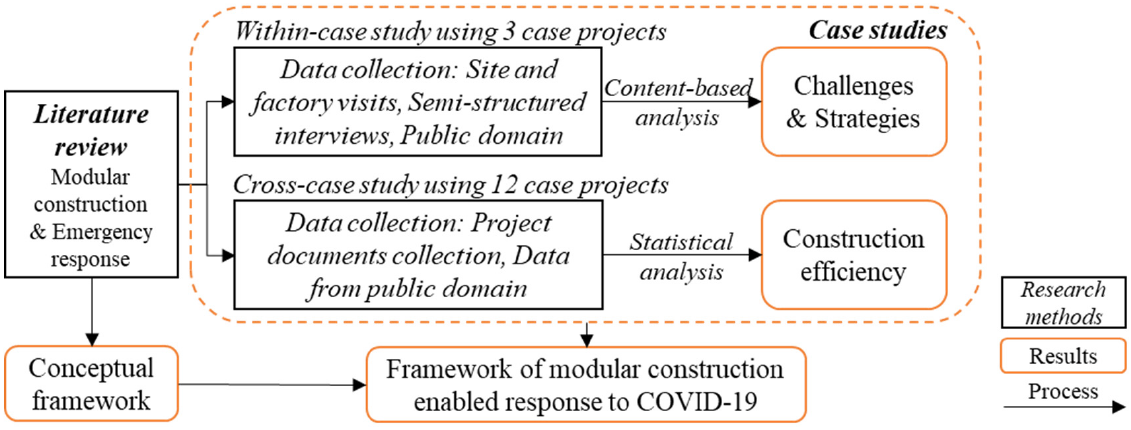
Figure 2. Overview of the research process with methods adopted and results derived.